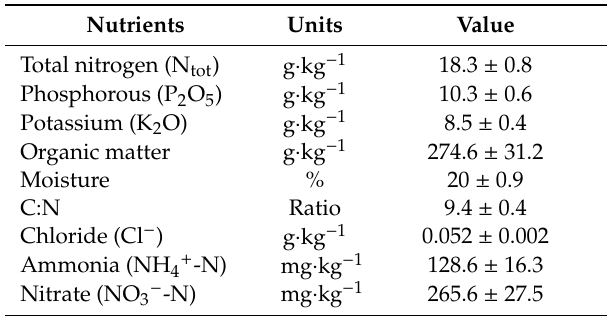
Table 4. Agronomic test results for cured compost from pile